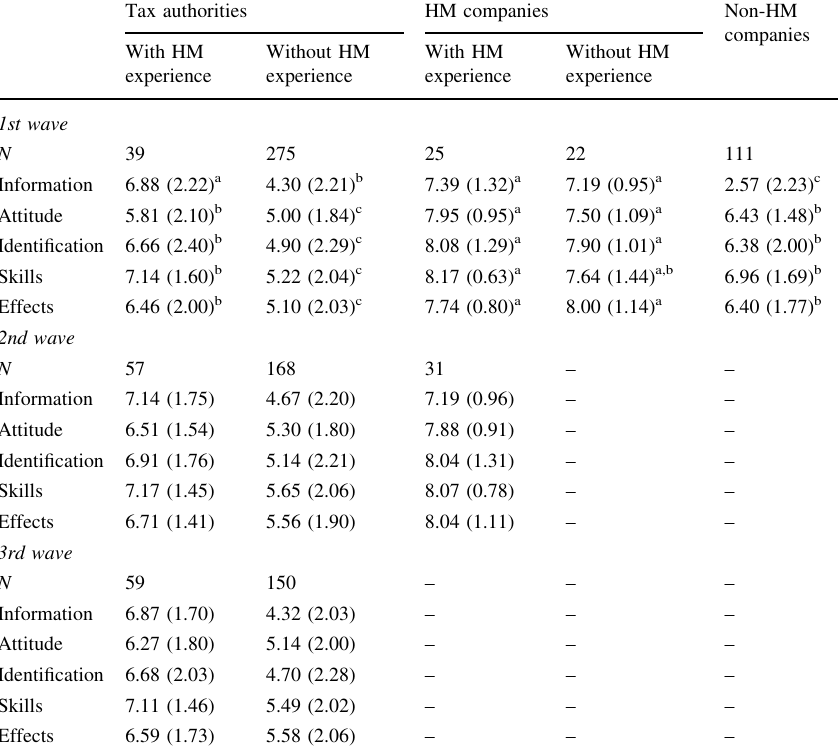
Table 5 Means and standard deviations of survey scales by survey wave and stakeholder groups (tax authorities with or without HM experience; HM company employees with or without HM exerience, and employees of companies not taking part in the HM